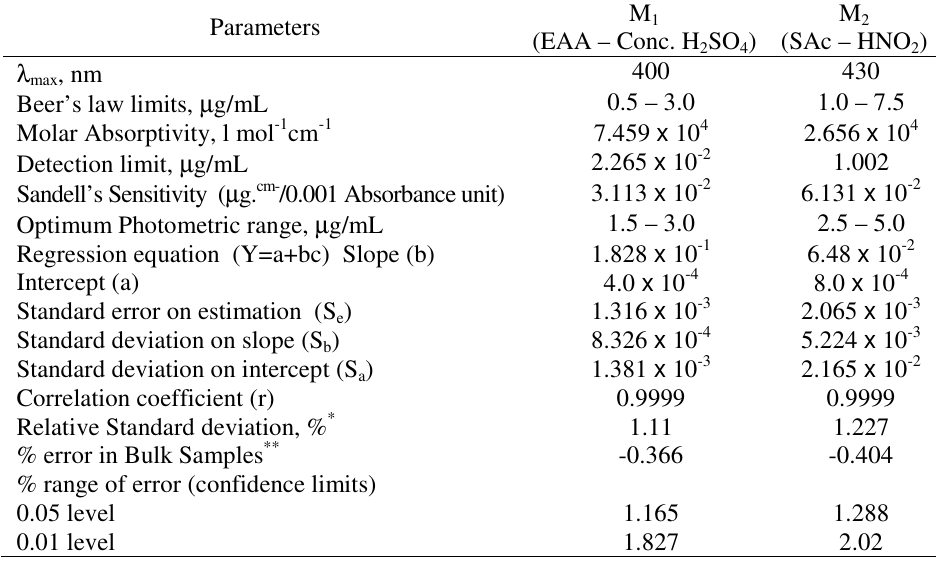
Table 1. Optical and regression characteristics, precision and accuracy of the proposed methods for